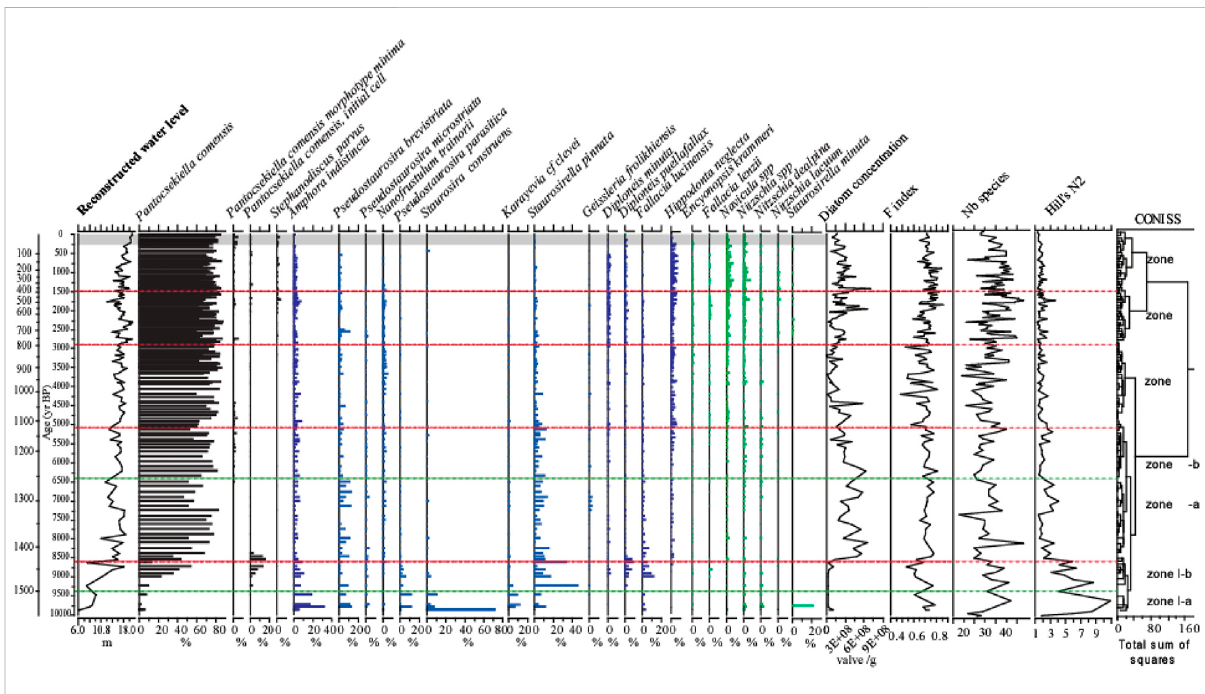
FIGURE 8 Summary diatom diagram for core KL 13-4. The curve on the left hand-side shows the reconstructed water level fl uctuations derived from the diatom-water level transfer function developed for Lake Kalakuli. Diatom zones are based on a stratigraphically constrained cluster analysis (CONISS), main zones marked by red dashed lines, sub-zones marked by green dashed lines. The grey band at the top of the sequence symbolizes the modern conditions with a lake level highstand. Planktonic taxa are on the left of the diagram, from P. comensis to S. cf parvus , all other taxa are benthic and split according to their apparent preference for the mid-depth (in blue) and shallow zones (in green). On the right hand-side are plotted the diatom concentration in the sediment (as an indicator of diatom productivity), the F-index that estimates the preservation of the assemblages, the number of species found in each sample and the Hill ’ s N2 diversity